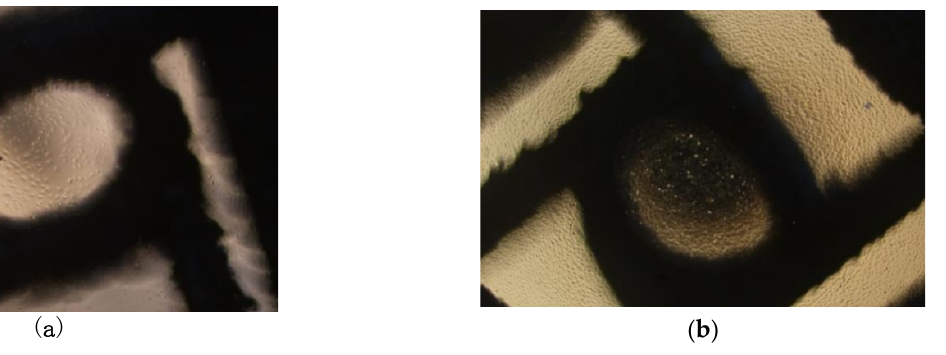
Figure 10. LPBF-manufactured scaffold co-cultured with HUVICs under light microscope: ( a ) co-cultured for 3 days; ( b ) co-cultured for 5 days.